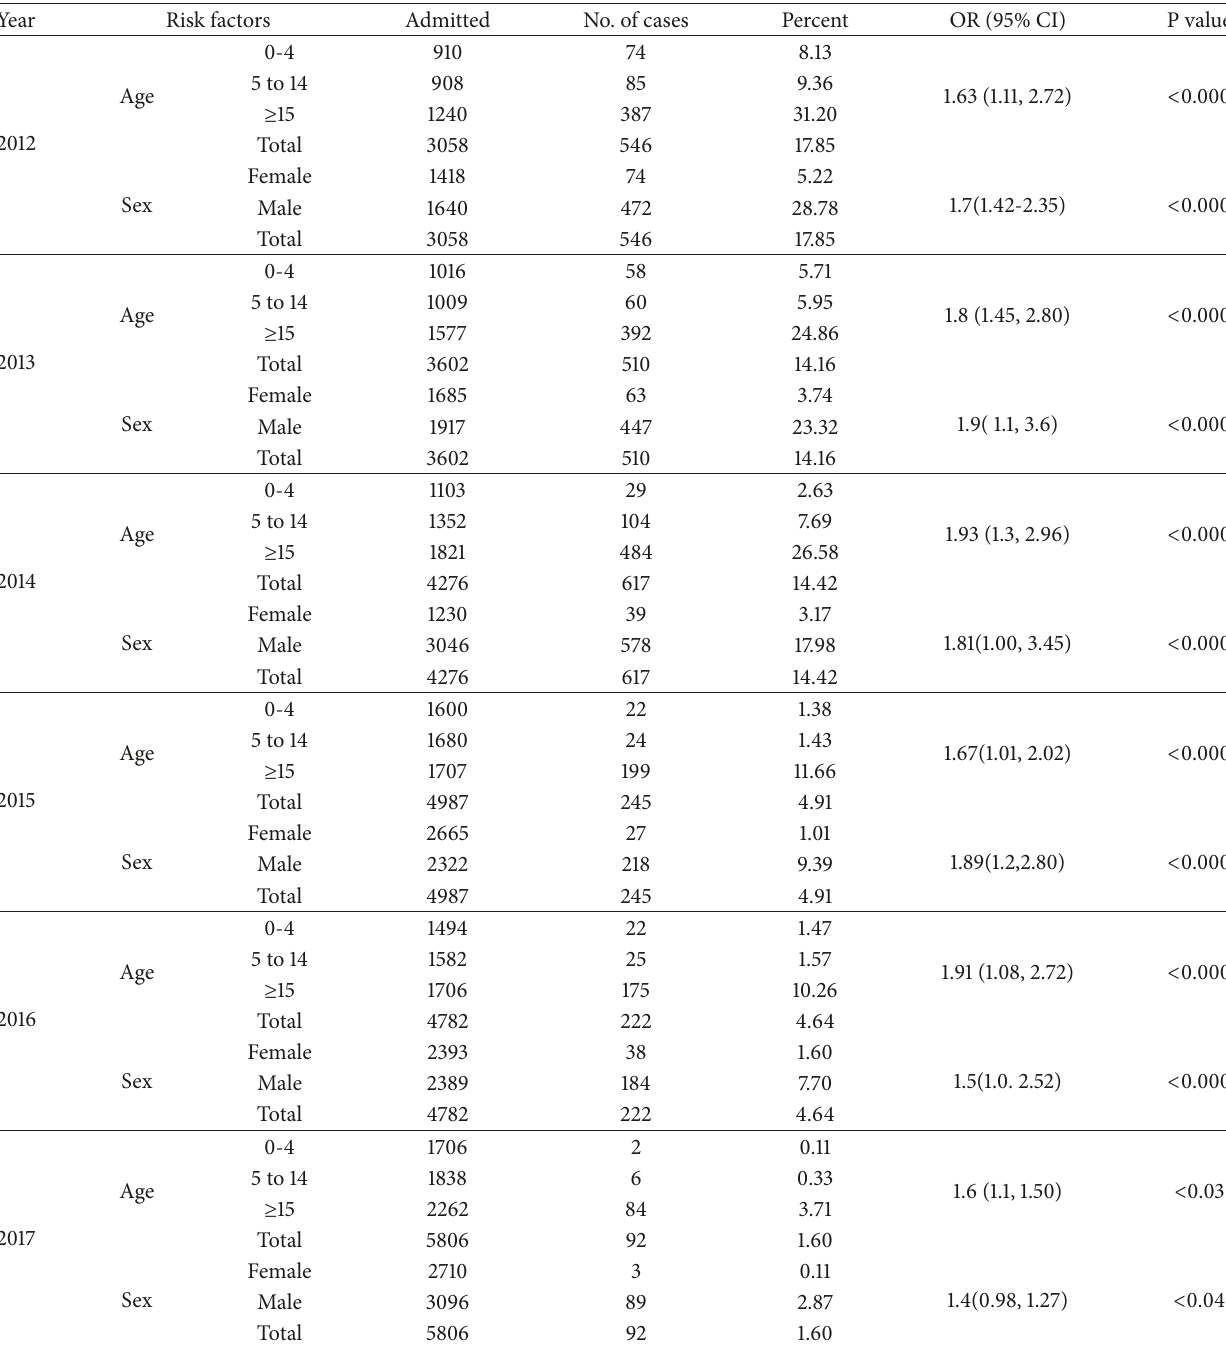
Table 3: Incidence of leishmaniasis in relation to age and sex with all diagnosed patients for